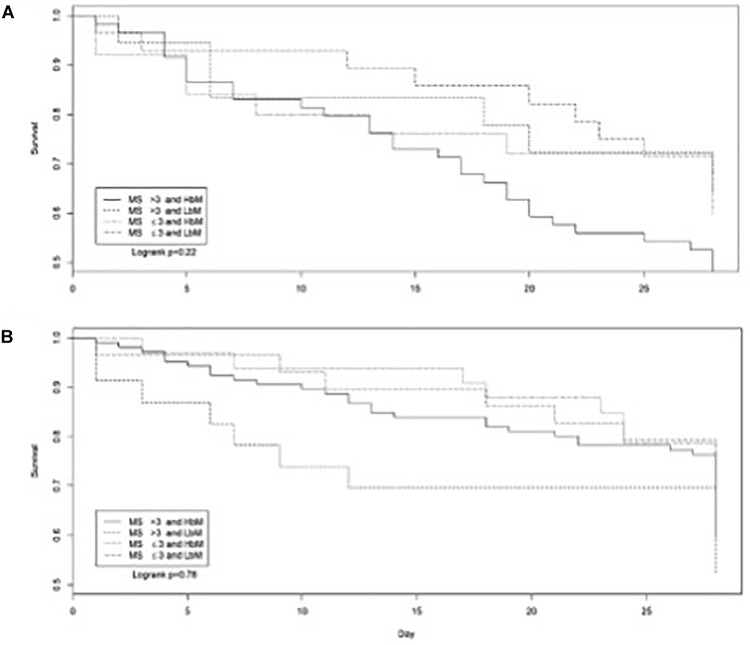
Survival curves for patients with candidemia (A) or invasive candidiasis proven by the isolation of Candida albicans, Candida tropicalis, Candida glabrata, Candida parapsilosis, and Candida dubliniensis from the peritoneum or other tissue or body fluid samples (B) according to the MS and β-Man profiles (restricted to the strains characterized regarding HβM and LβM) (1, MS > 3 and HβM; 2, MS > 3 and LβM; 3, MS ≤ 3 and HβM; 4, MS ≤ 3 and LβM).